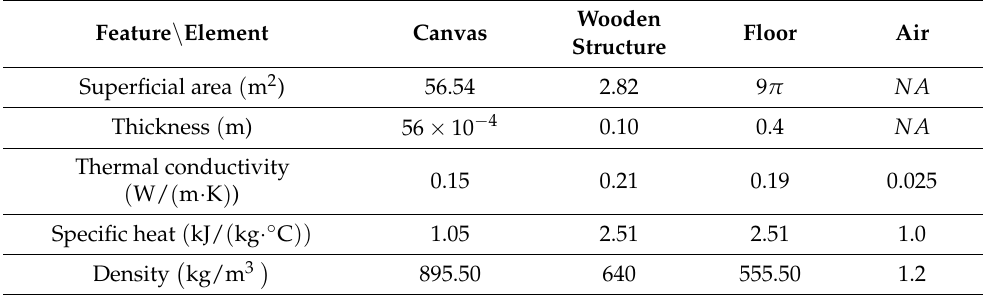
Table 1. Geometric and physical